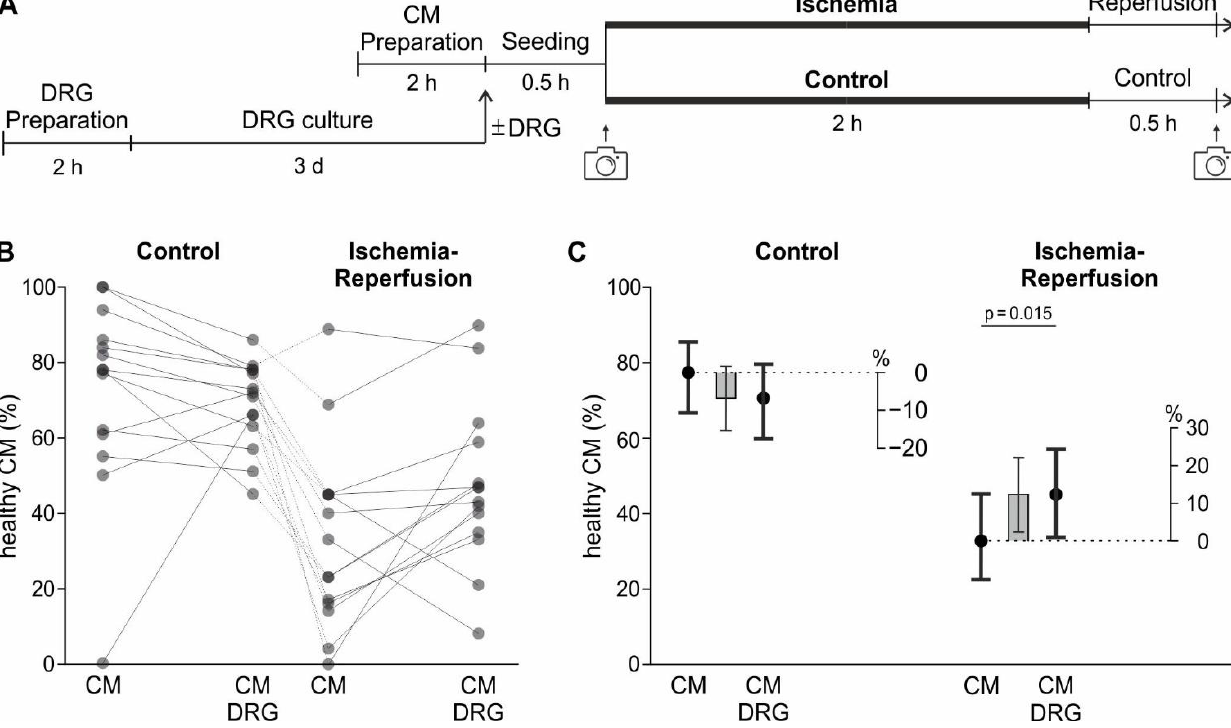
Figure 3. Sensory neurons increased the survival of cardiomyocytes in a model of IR. ( A ) Experimental timeline for the cardiomyocytes, including timing of image acquisition for survival analysis. In experimental groups with sensory neurons from dorsal root ganglia (DRG), these were prepared and seeded three days earlier. ( B ) Percentage of healthy CM at the end of the cellular model for IR, with 2 h of mimicked ischemia and 0.5 h mimicked reperfusion. Every dot represents the mean of one experiment, and those experiments conducted in parallel are connected. ( C ) Estimated survival probabilities for each group are shown as black dots ± 95% CI and estimated differences are shown as grey bars ± 95% CI.